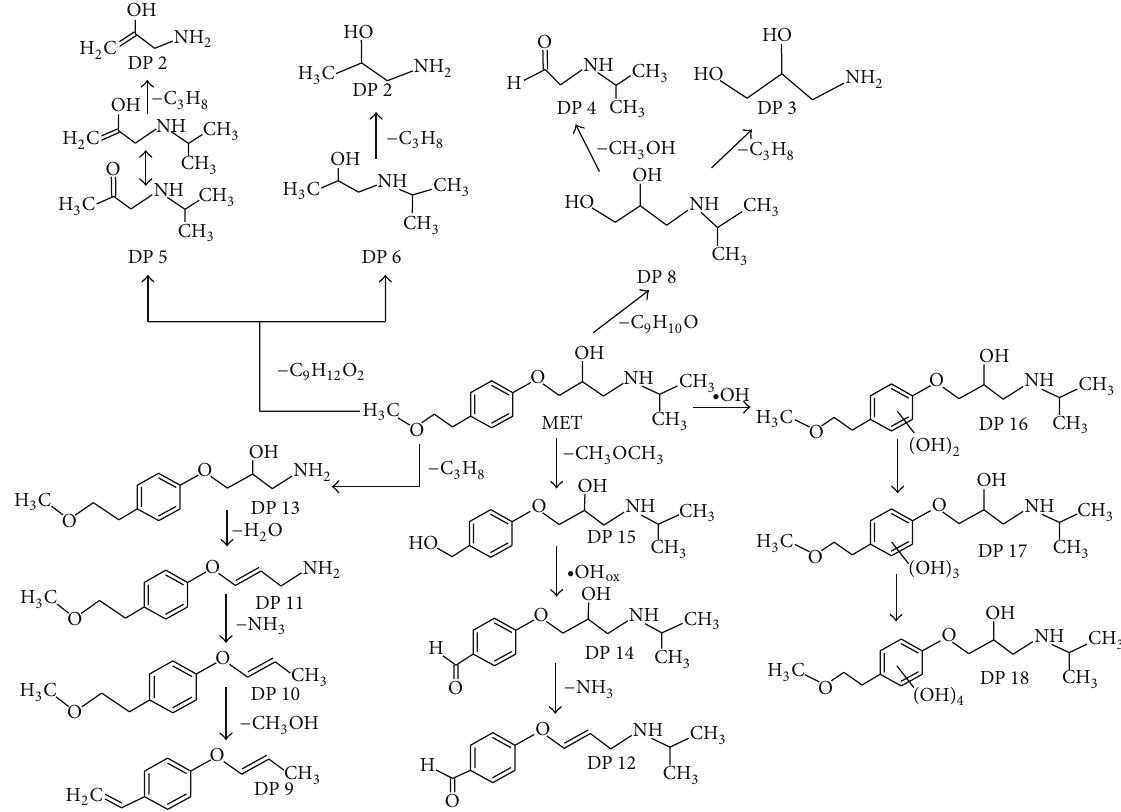
Figure 6: Proposed pathways for the degradation of